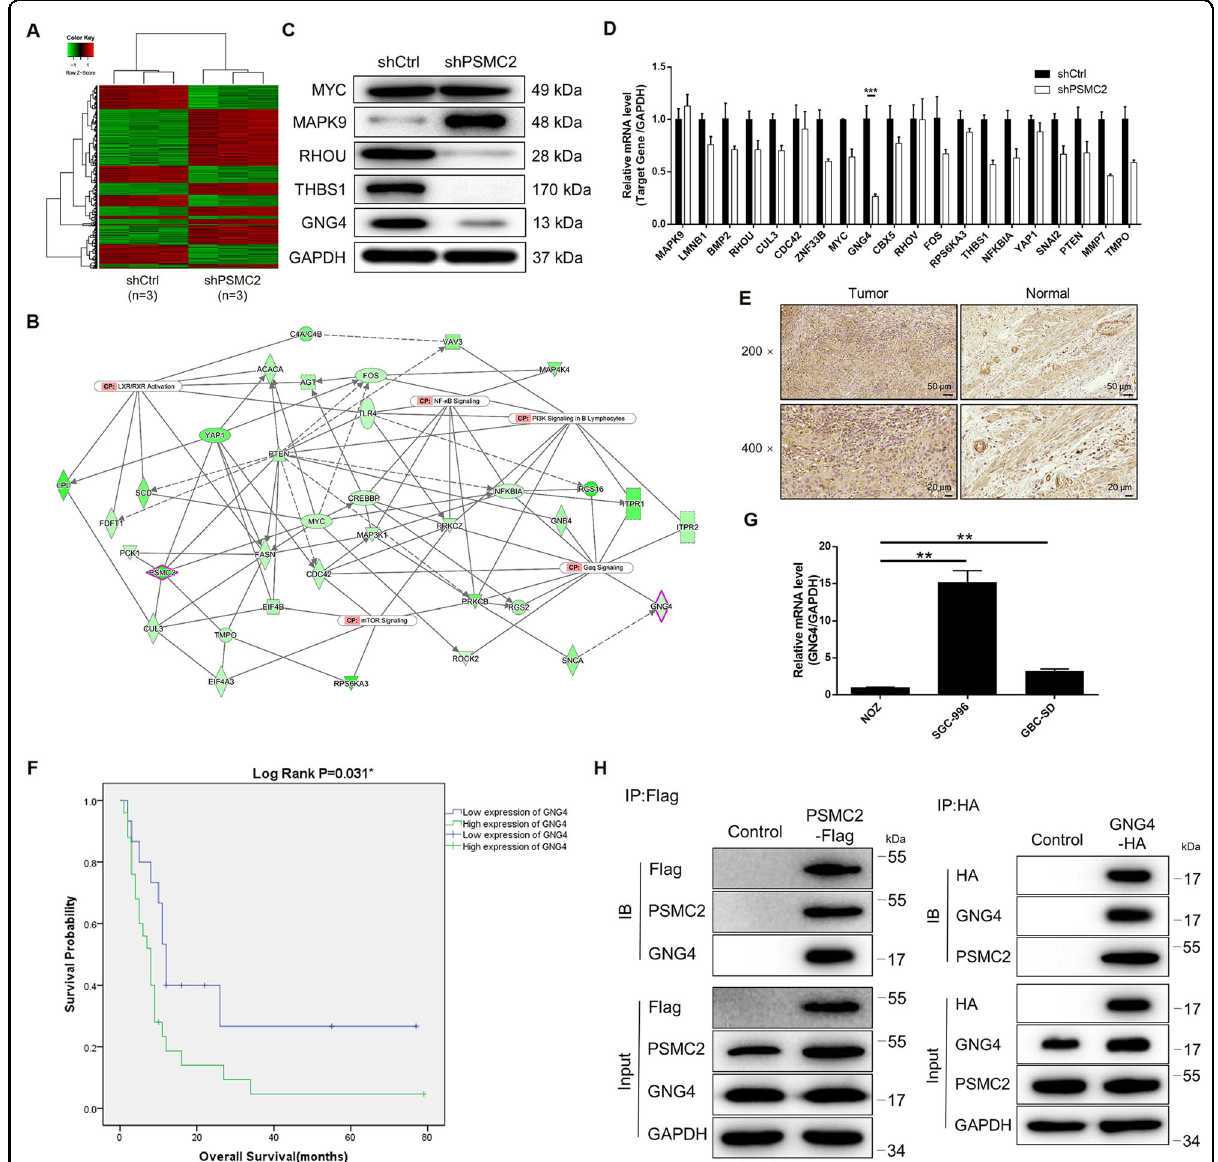
Fig. 3 The exploration and veri fi cation of downstream underlying PSMC2 induced regulation of GBC. A Primeview human gene expression array was performed to identify the differentially expressed genes (DEGs) between shPSMC2 and shCtrl groups of GBC-SD cells. B A PSMC2-induced interaction network was established based on IPA analysis. qPCR ( C ) and western blotting ( D ) were used to detect the expression of several selected DEGs in GBC-SD cells with or without PSMC2 knockdown. E The expression of GNG4 in GBC tissues and normal tissues was evaluated by IHC analysis. F Kaplan – Meier survival analysis showed that high expression of GNG4 predicts poor prognosis of GBC patients. G The mRNA expression of GNG4 in GBC cell lines was detected by qPCR. The representative images were selected from at least 3 independent experiments. H Co-IP assay was performed to show the direct interaction between PSMC2 and GNG4. Data were shown as mean ± SD. ** P < 0.01, *** P <